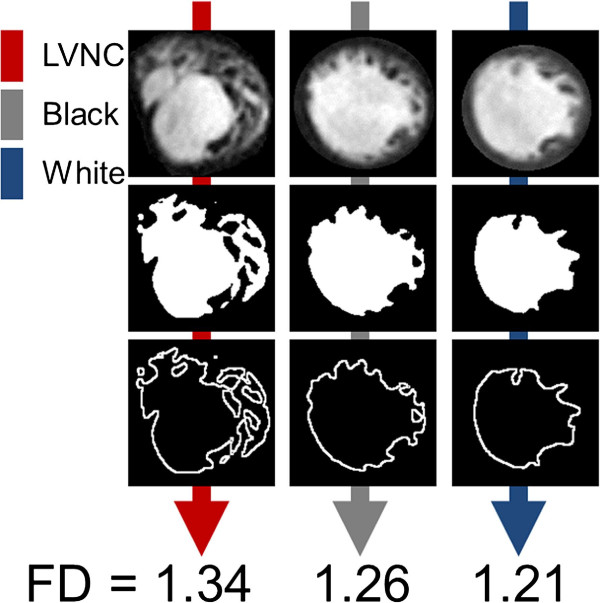
Illustrative left ventricular slices from each of the three study populations with corresponding FDs. Fractal analysis of each slice generates a value for the FD. In this study we demonstrate that FD differs significantly between LVNC, healthy black and white populations. Abbreviations as in Figure 1.